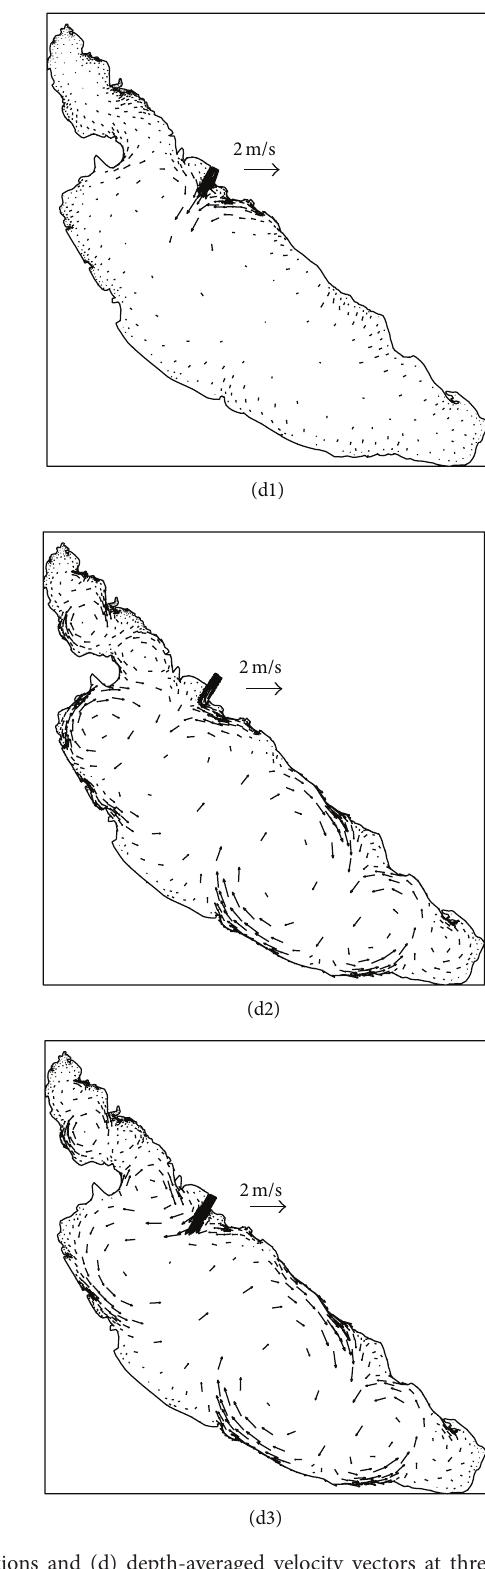
Figure 4: Spatial distributions of predicted (c) contaminant concentrations and (d) depth-averaged velocity vectors at three different simulation times (from top to bottom 𝑡 = 1 h, 3 days, and 6 days) for tidal flushing through Inlet 𝑁